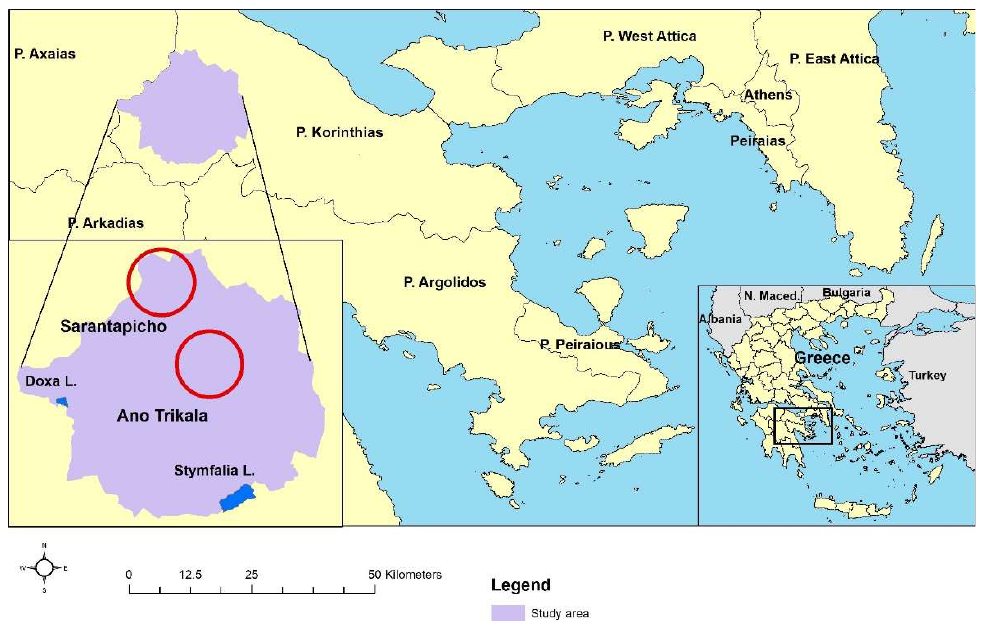
Figure 1. The study area in Mt Zireia in the Peloponnese peninsula. The red circles indicate the selected sites.